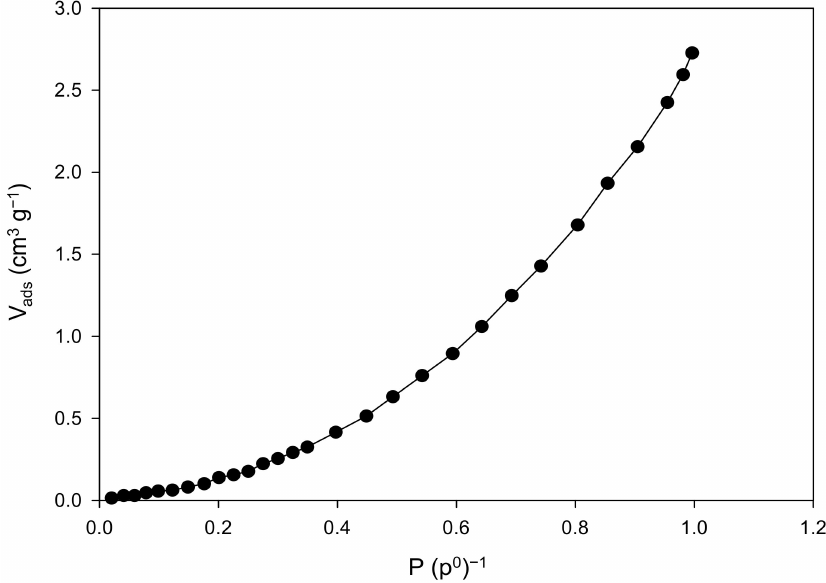
Figure A2. N 2 physisorption isotherm of MCP.